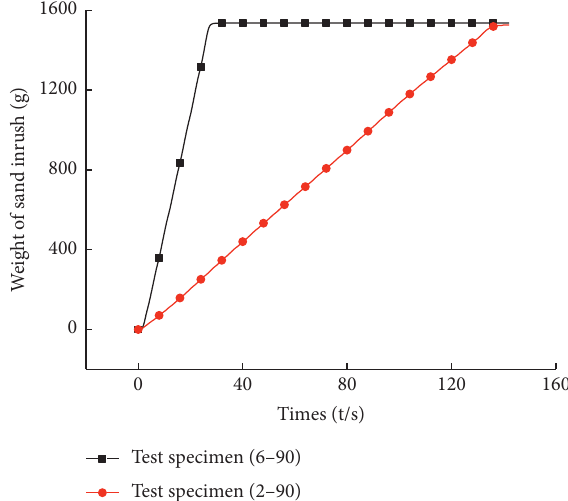
Figure 7: The curves of the specimen of sand inrush.